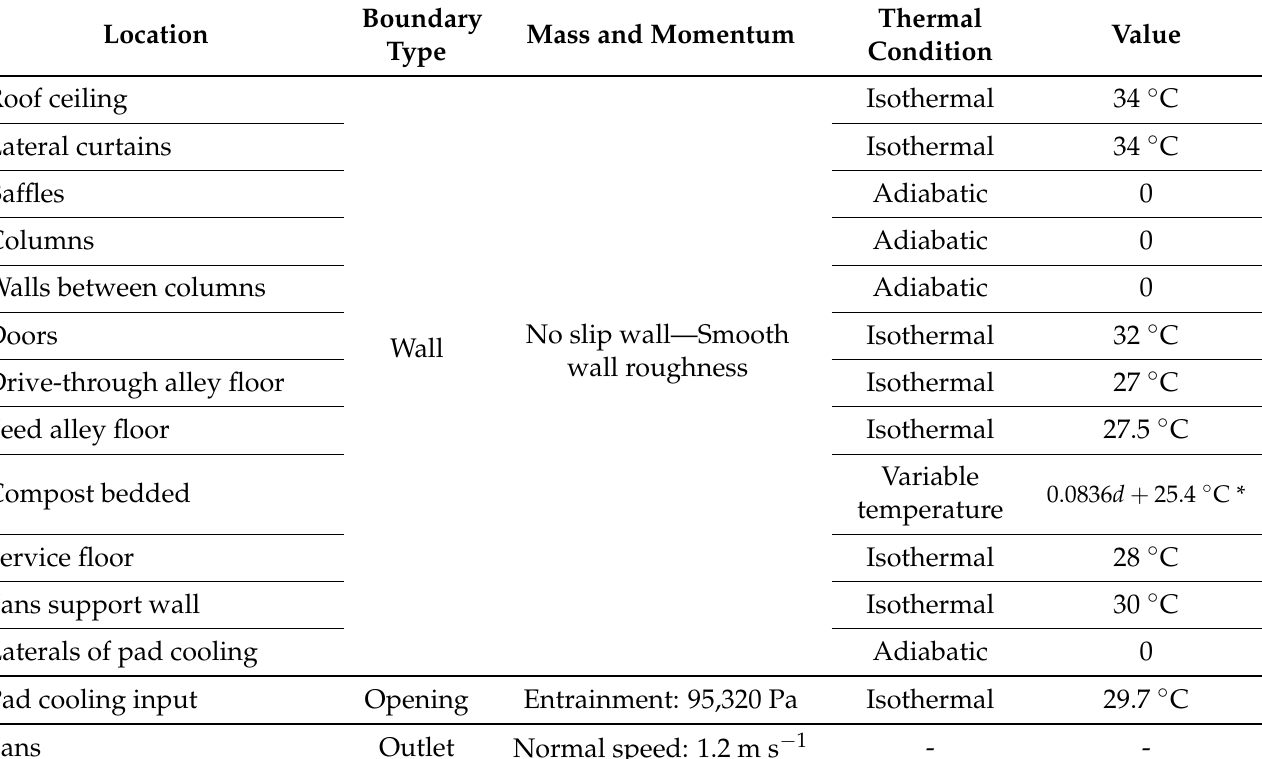
Table 1. Boundaries conditions used in the CFD compost dairy barn